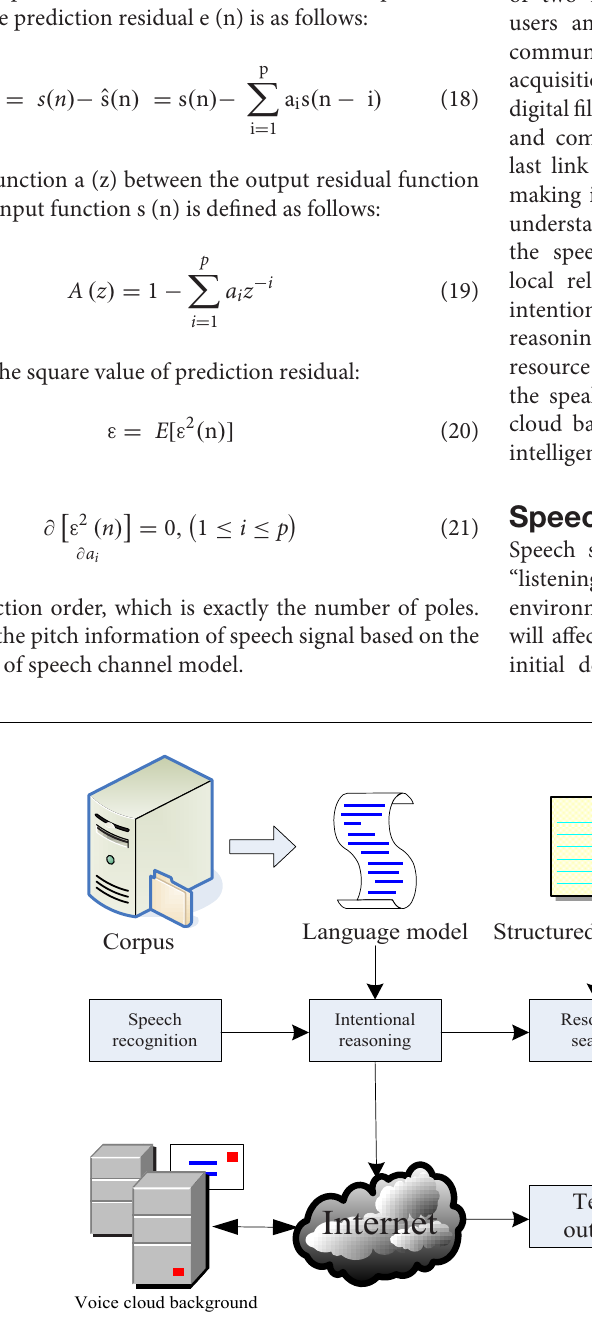
FIGURE 2 | Voice interaction